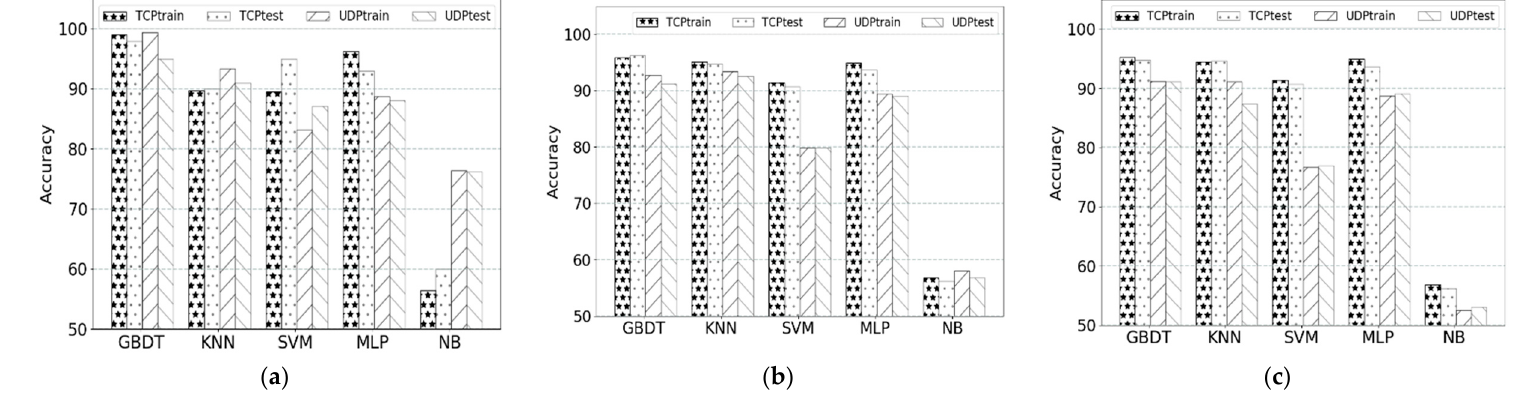
Figure 3. Accuracy comparison. ( a ) 1 k data; ( b ) 10 k data; ( c ) 100 k data.